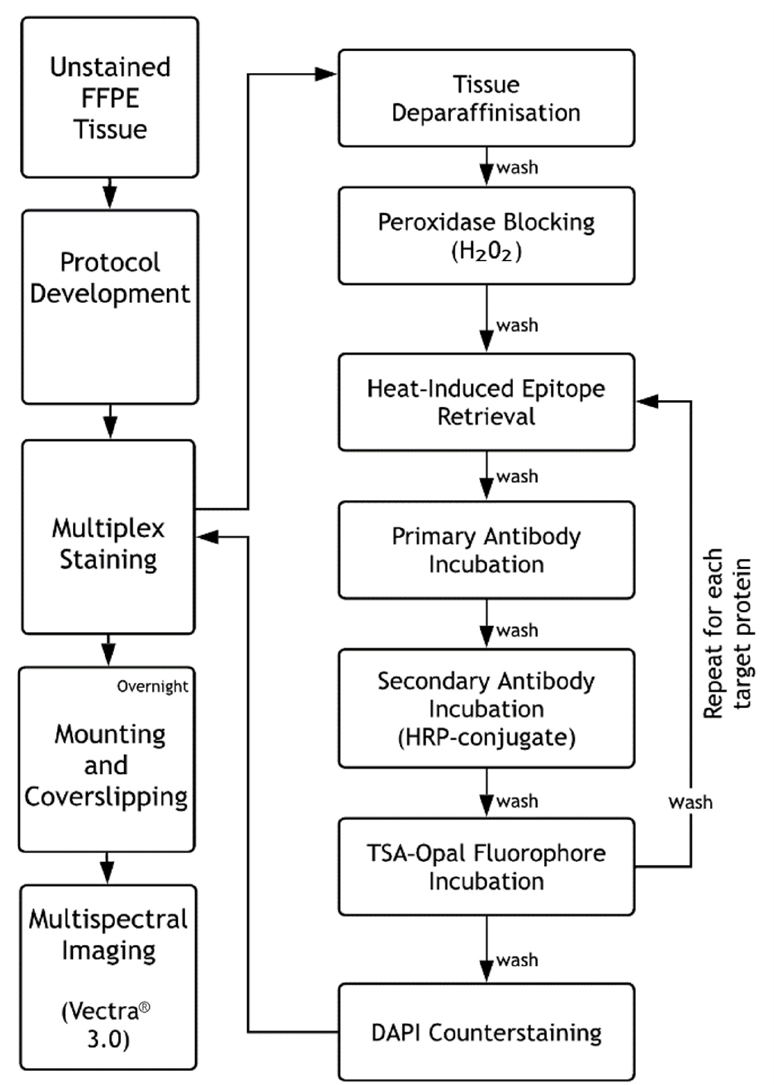
Figure 1. Flowchart of Opal™-TSA multiplex immunohistochemistry assay. Following protocol development and FFPE tissue section preparation, specimens undergo sequential target staining through repetition of HIER and striping, blocking, primary antibody incubation, secondary antibody incubation Opal™ signal generation, followed by DAPI counterstaining, slide